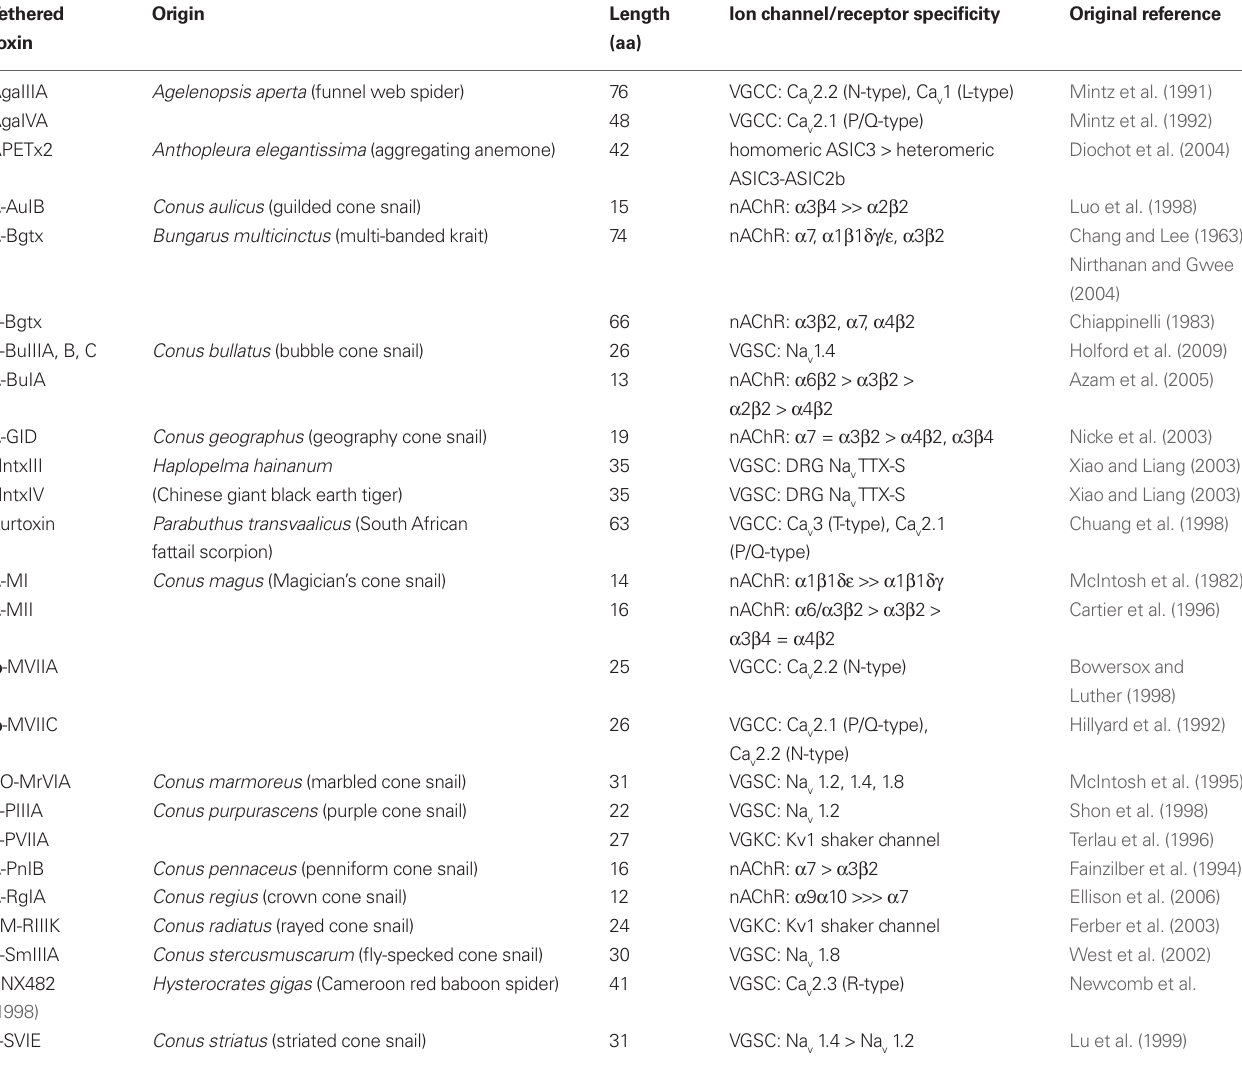
Table 1 | Examples of venom peptide toxins used for generation of tethered modulators and corresponding targeted receptors/ion